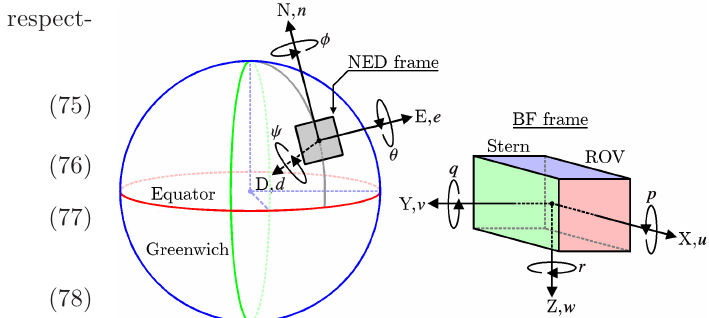
Figure 2: NED and BF reference